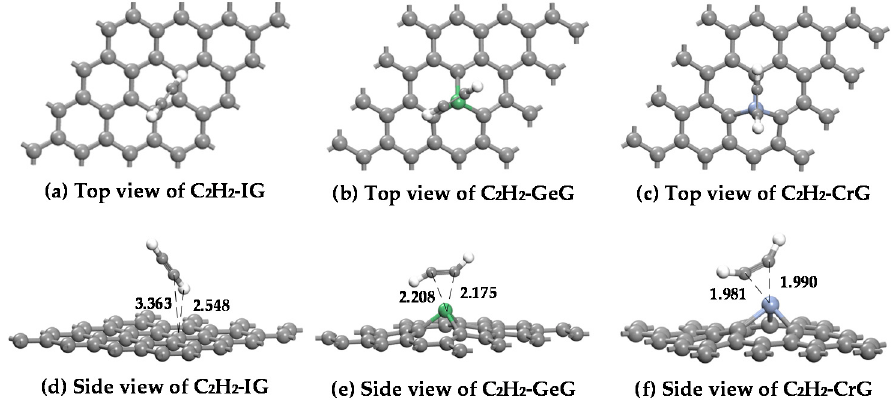
Figure 10. The optimized structures of C 2 H 2 adsorbed on IG ( a , d ), GeG ( b , e ), and CrG ( c , f ) systems. Table 4. The geometrical parameters of C 2 H 2 adsorption systems.